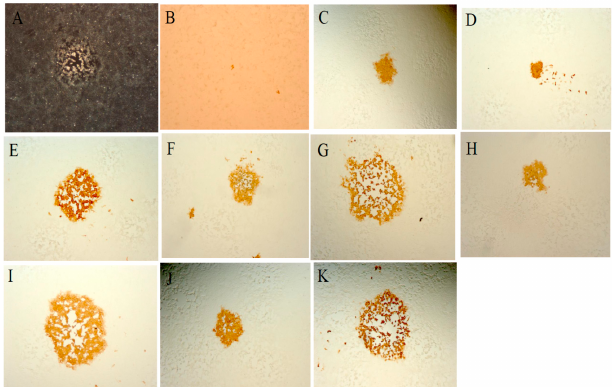
Figure 4. Plaque formation by hybrid progeny viruses in co-infected and superinfected Vero cells. Cells were co-infected with the parental viruses at a m.o.i. of 5.0 for each virus. Cells were harvested three days post infection, freeze-thawed and sonicated. The harvested cell suspension was used to inoculate fresh monolayer of Vero cells. Recombinant viruses expressing the influenza virus hemagglutinin (HA) transgene were detected by standard immunostaining. For superinfection 1, Vero cells were infected first with MVA-HANP, adsorption was for an h. Medium was removed and cells were washed twice with cold PBS and then superinfected with fCPXV at two h post primary virus infection (ppi). In superinfection 2, cells were first infected with fCPXV and superinfected with MVA-HANP at two h ppi. ( A ) Vero cells infected with parental strain fCPXV; ( B ) Vero cells infected with parental strain MVA-HANP; ( C – E ), Representative panel of Vero cells co-infected with parental strains; ( F – H ) Panel of Vero cells in superinfection 1; and ( I – K ) Panel of Vero cells in superinfection 2. All panels show representative fields at approximately 200 ×